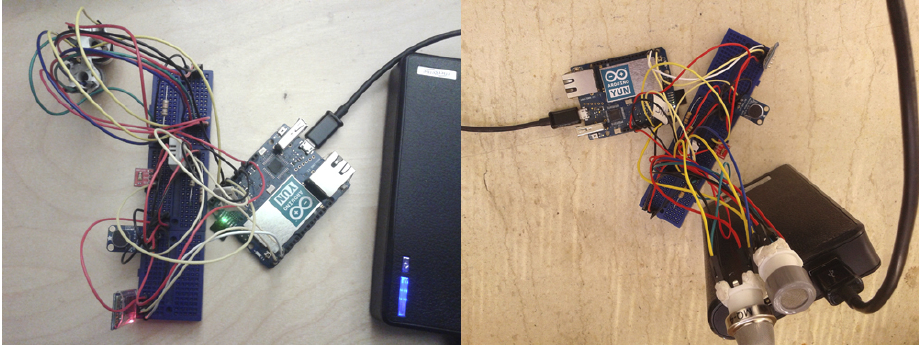
Figure 2. Sensor node in bulk